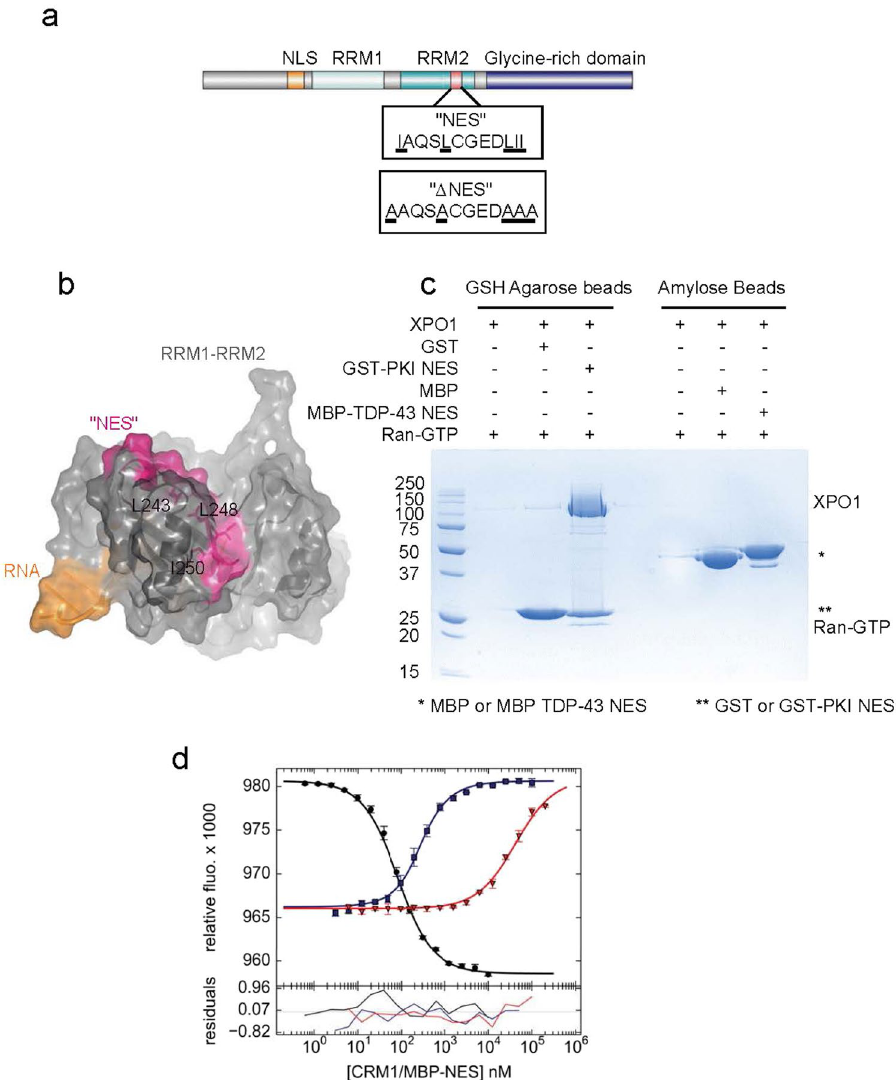
Figure 1. The putative NES in TDP-43 is not solvent exposed and has weak affinity for XPO1. ( a ) Domain organization of TDP-43, formatted using IBS Cuckoo 43 . NLS: Nuclear Localization Signal, residues 82–98. RRM1: RNA Recognition Motif 1, residues 106–165. RRM2: RNA Recognition Motif 2, residues 191–257. “NES”: putative Nuclear Export Signal, residues 239–250. “ ∆ NES”: set of point mutations reported to disrupt putative NES, I239A, L243, L248A, I249A, I250A 18 . Glycine-Rich domain: residues 270–414. ( b ) NMR solution structure of the TDP RNA binding domain (RRM1-RRM2) 20 . Shown is the cartoon overlaid by a partly transparent solvent accessible surface. Residues comprising the putative NES have been colored magenta. The side chains of some critical hydrophobic residues – L243, L248, and I250 – are shown as sticks. ( c ) In vitro pull-down assay (Coomassie/SDS-PAGE) of purified human XPO1 binding to immobilized GST-NES PKI (on GSH agarose beads) or MBP- NES TDP (on amylose beads) in the presence of Ran-GTP (GSP1(179ter, Q71L)). ( d ) Competition differential bleaching assay. Binding of FITC-NES PKI to XPO1 in the presence of excess RanGTP (GSP1 (179ter, Q71L)), measured by differential bleaching (blue line) Bleaching of a fluorescently labeled control NES, FITC-NES PKI , decreases with increasing XPO1 concentration (black line). MBP-NES PKI competes with FITC-NES PKI for XPO1 binding (blue line). MBP-NES TDP-43 poorly competes with FITC-NES PKI for XPO1 binding (red line). Relative fluorescence of triplicate experiments are plotted on top with data points representing mean and standard deviation. Data fit residuals are plotted